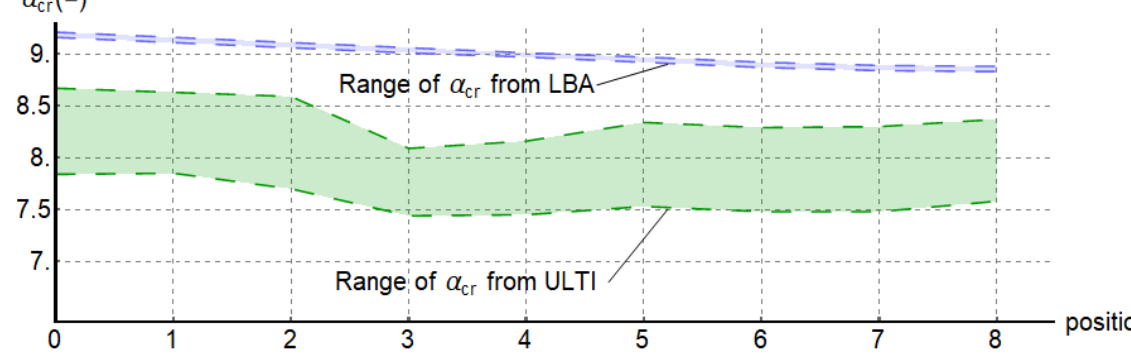
Figure 15: Resultant ranges of the critical load factors for the LBA and ULTI analysis.